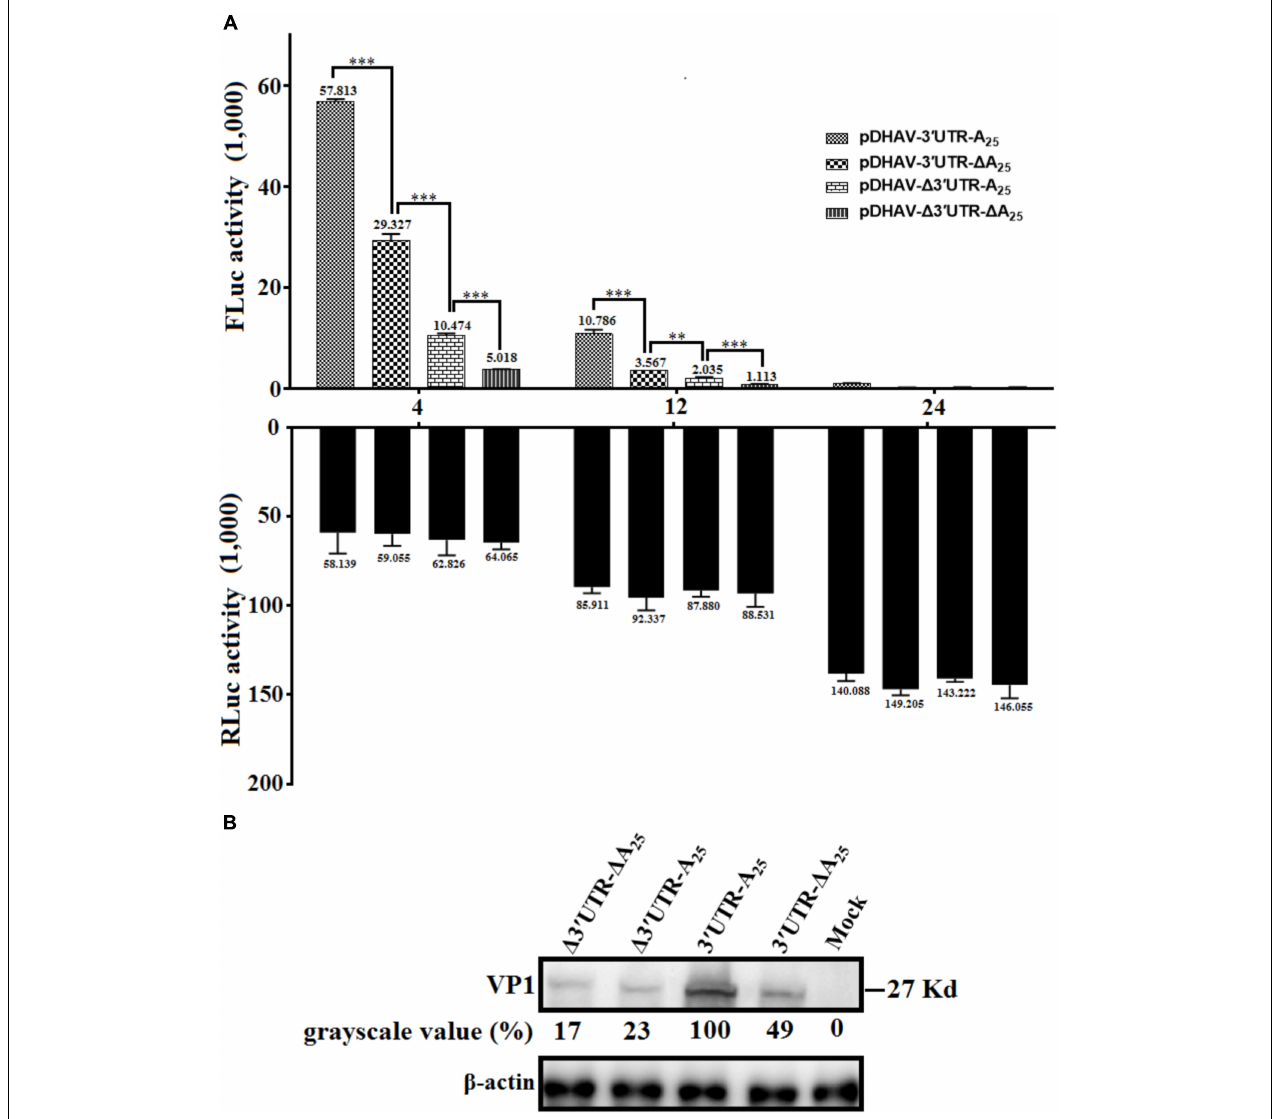
FIGURE 6 | The 3 (cid:48) UTR and poly(A) tail function as individual elements to stimulate IRES-mediated translation. (A) The in vitro transcribed products of plasmid pDHAV-3 (cid:48) UTR- (cid:49) A 25 or pDHAV- (cid:49) 3 (cid:48) UTR-A 25 were transfected into DEFs, and reporter RNAs of pDHAV-3 (cid:48) UTR-A 25 or pDHAV- (cid:49) 3 (cid:48) UTR- (cid:49) A 25 were used as positive or negative controls, respectively. The stimulation values between 3 (cid:48) UTR-containing RNAs and poly(A)-containing RNAs were compared. 0.1 µ g of pGMLR-TK plasmid was co-transfected with reporter RNAs, and the RLuc activity was measured at each detection point. Bars represent the means ± standard deviations of three replicate experiments. ∗∗∗ P < 0.001, ∗∗ P < 0.01. (B) After transfection of pR-DHAV-1-3 (cid:48) UTR- (cid:49) A 25 or pR-DHAV-1- (cid:49) 3 (cid:48) UTR-A 25 into DEFs, cell lysates were collected at 4 hpt and used for western blot analysis, with pR-DHAV-1 and pR-DHAV-1- (cid:49) 3 (cid:48) UTR- (cid:49) A 25 used as controls. The anti-DHAV-1 monoclonal antibody